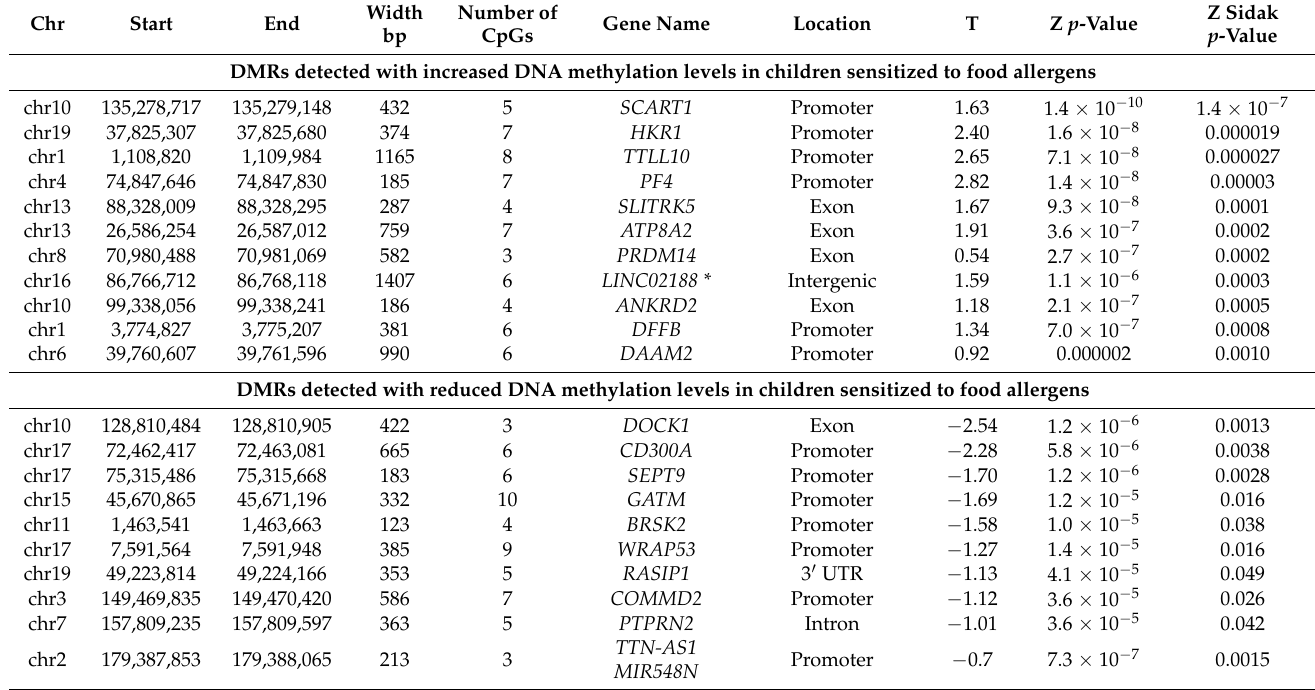
Table 4. Differentially methylated regions (DMRs) in children PBMCs at 5 years associated with IgE sensitization to food allergens at 5